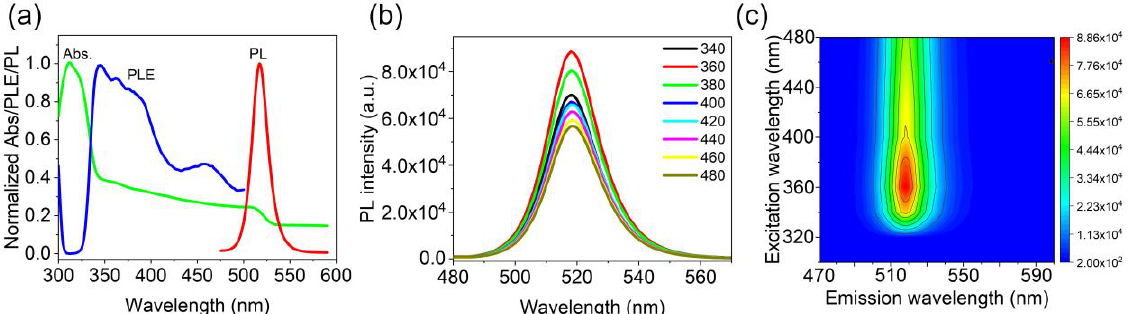
Figure 3. Optical properties of CsPbBr 3 /Cs 4 PbBr 6 microcrystals: ( a ) normalized photoluminescence (PL) (excited by 365 nm), photoluminescence excitation (PLE) (monitored at 520 nm), and ultraviolet-visible (UV-Vis) absorption spectra; ( b ) PL intensity of the samples under different excitation wavelengths; ( c ) contour plot of the colored PL intensity measured as a function of excitation wavelength.